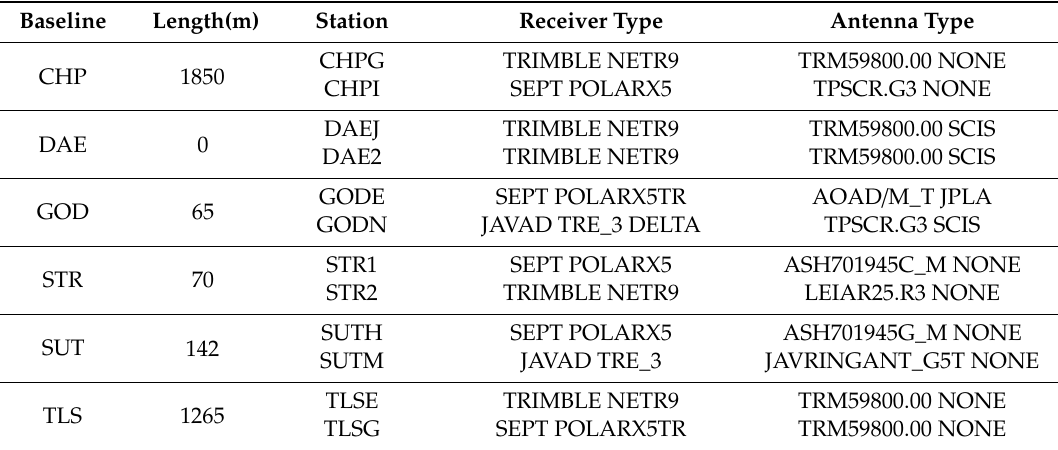
Table 1. Station information and baseline